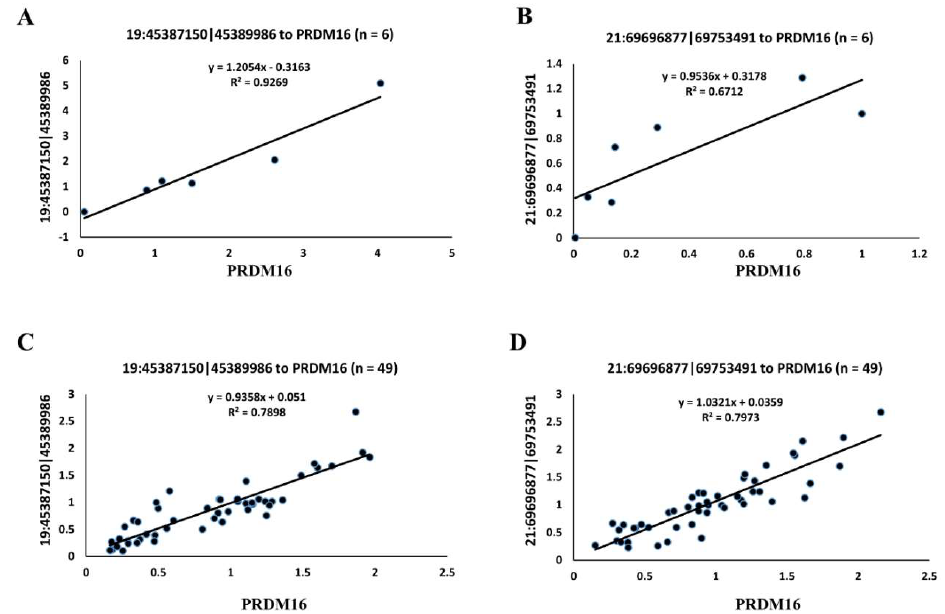
Figure 3. Validation of the two circRNAs with a strong correlation to PRDM16 by qRT-PCR. The y -axis shows the relative expression of circRNA and PRDM16 . Pearson’s correlation coe ffi cients between circRNA and PRDM16 based on their relative expression were calculated to yield an r -value. ( A ) Validation for 19:45387150 | 45389986-PRDM16 in young and adult bu ff alo, n = 6. ( B ) Validation for 21:6969877 | 69753491-PRDM16 in young and adult bu ff alo, n = 6. ( C ) Validation